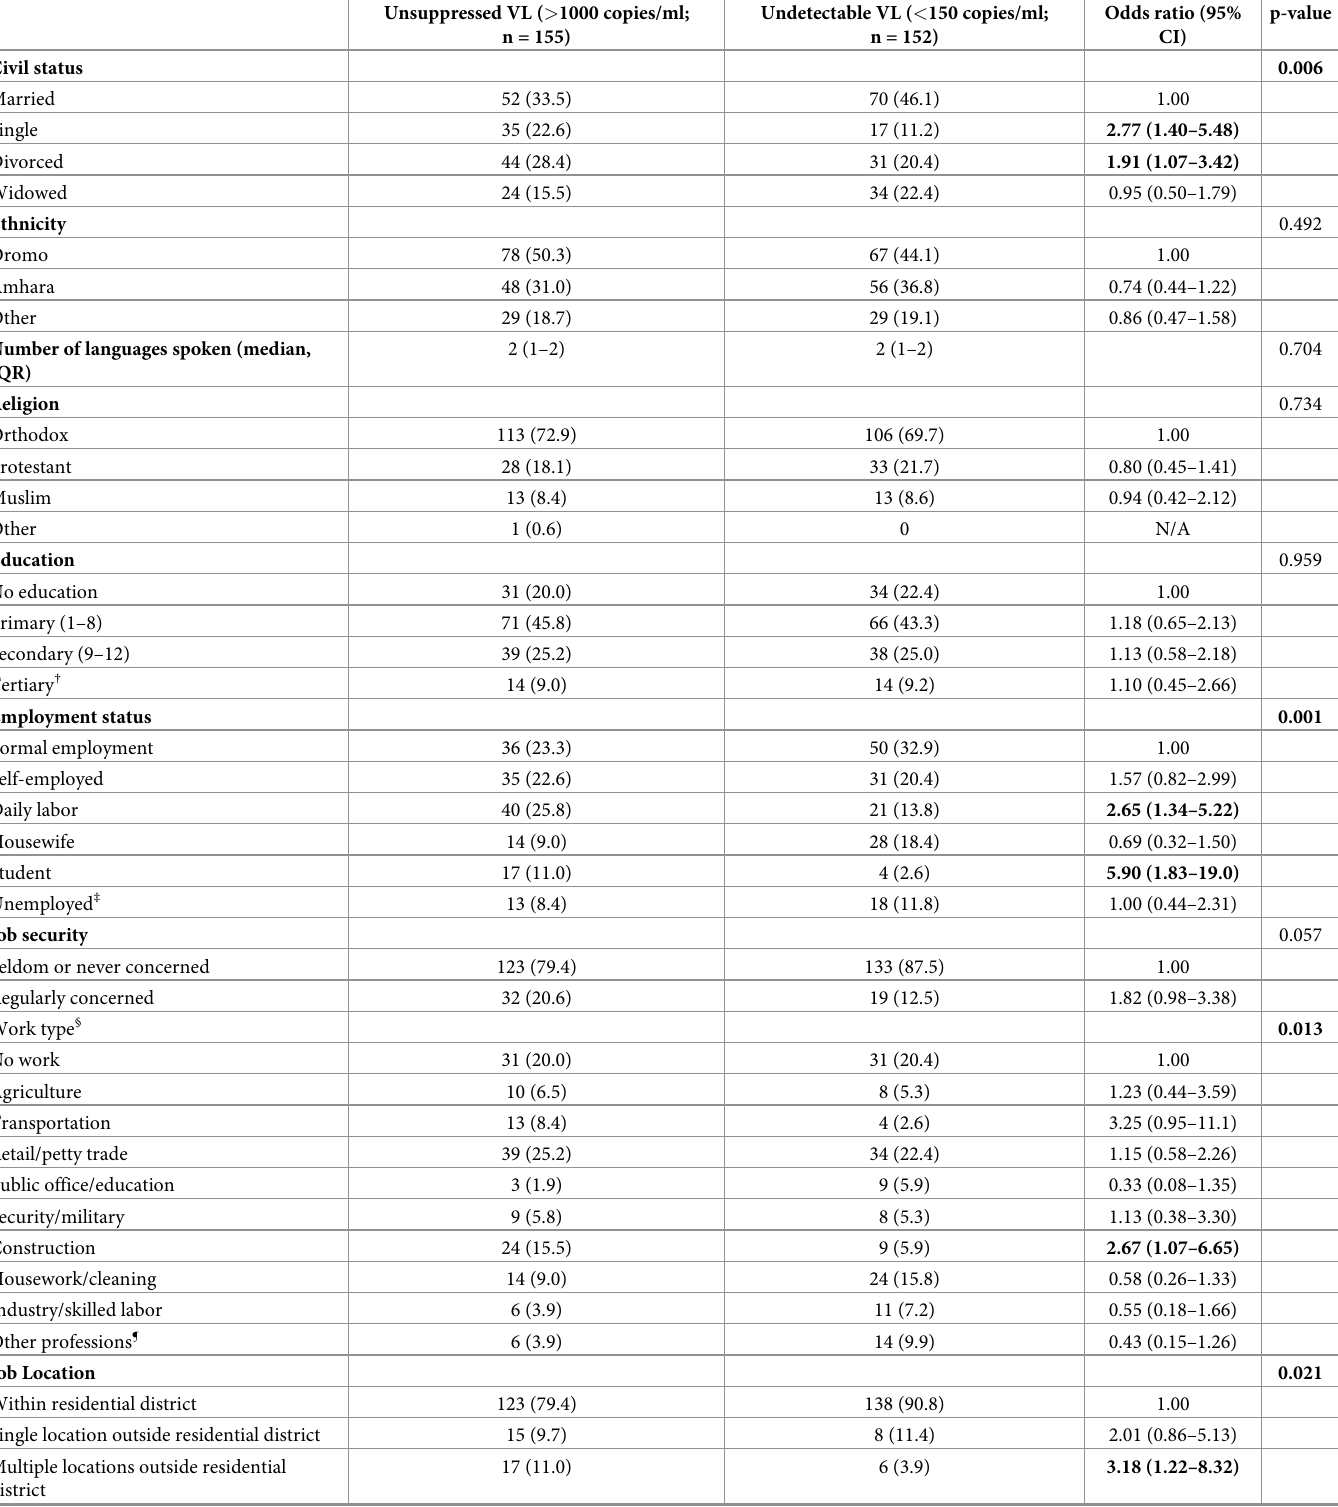
Table 2. Comparison of sociodemographic characteristics of study participants on ART with lack of virological suppression and with undetectable viral